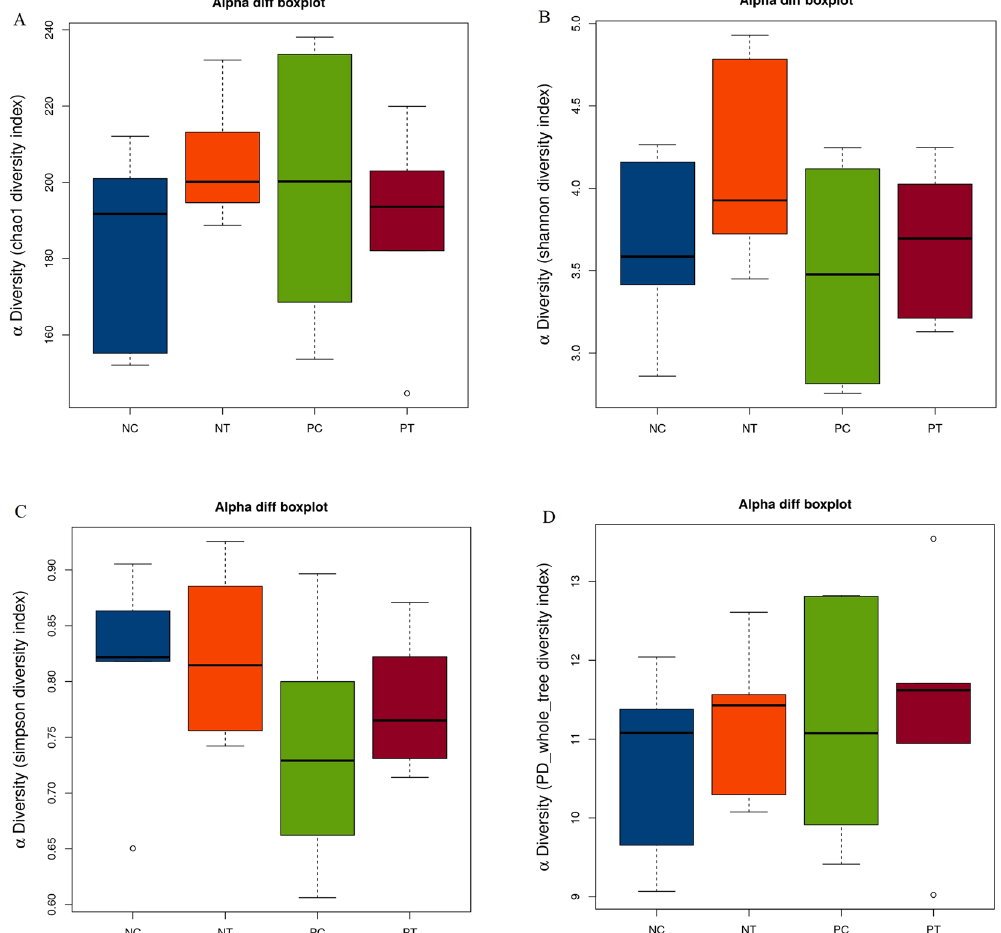
Figure 7. Effect of dietary E . faecium 11181 on the cecal microbiota α -diversity indices (in cecal feces) of broiler chickens challenged with NE at d 26 (n = 6). ( A ) Chao diversity index. ( B ) Shannon diversity index. ( C ) Simpson diversity index. ( D ) PD whole tree diversity index. NC = Non-NE-infected + no E. faecium treatment, NT = non-NE-infected + E. faecium treatment, PC = NE-infected + no E. faecium treatment, PT = NE- infected + E. faecium